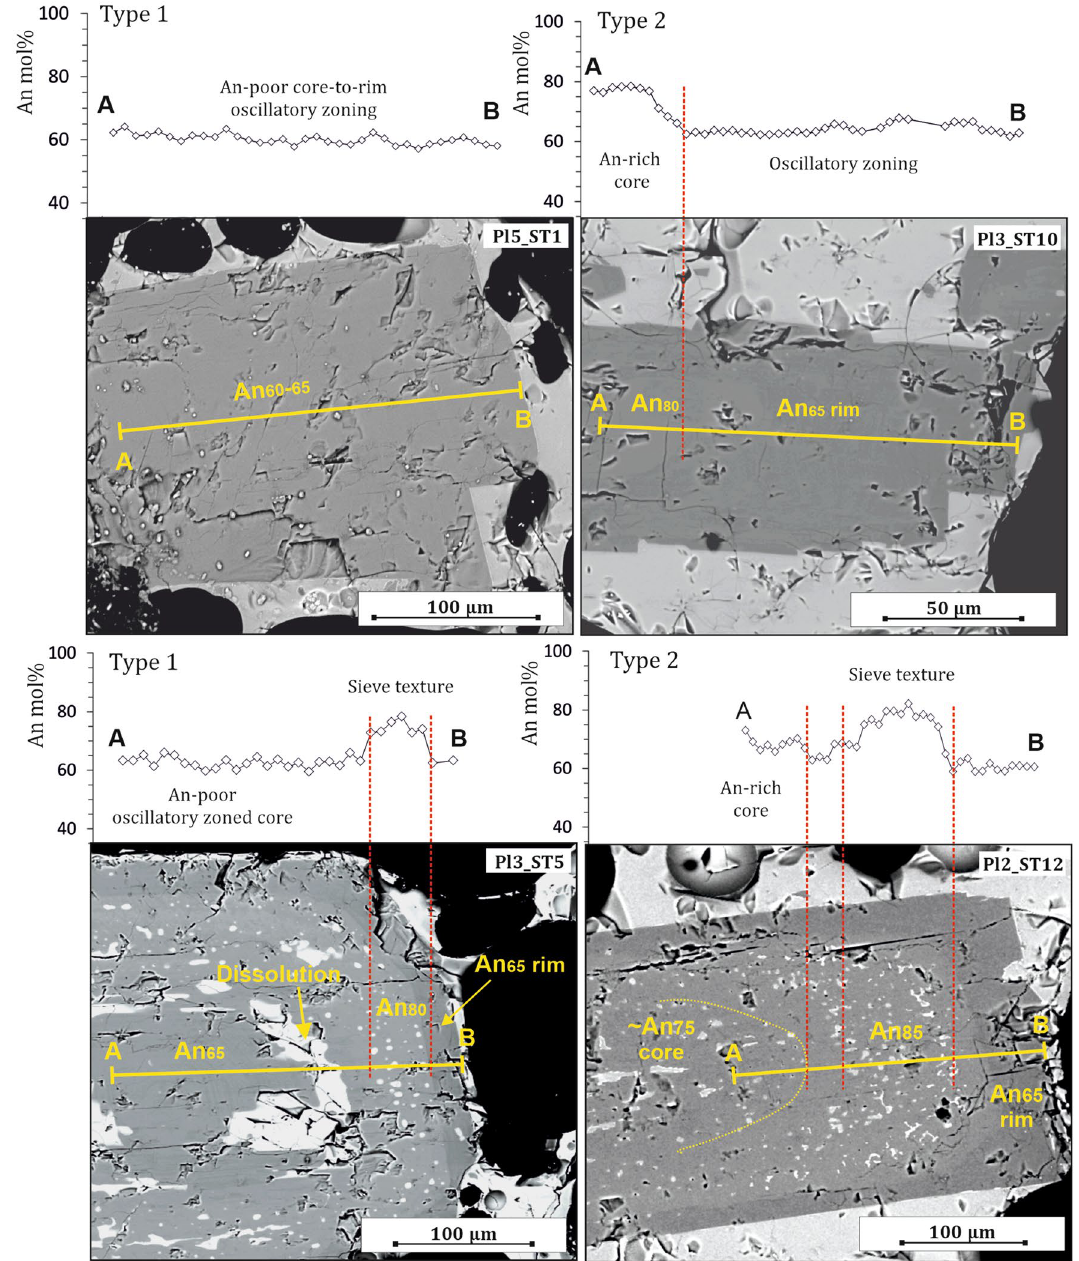
Figure 3. Core-to-rim An mol% profiles, coupled with BSE images of plagioclase crystals representing the two dominant zoning types, i.e. Type 1 (low-An core composition) and Type 2 (high-An core), defined in this study. Yellow straight solid lines, indicated as A–B, mark the analyzed profile of the